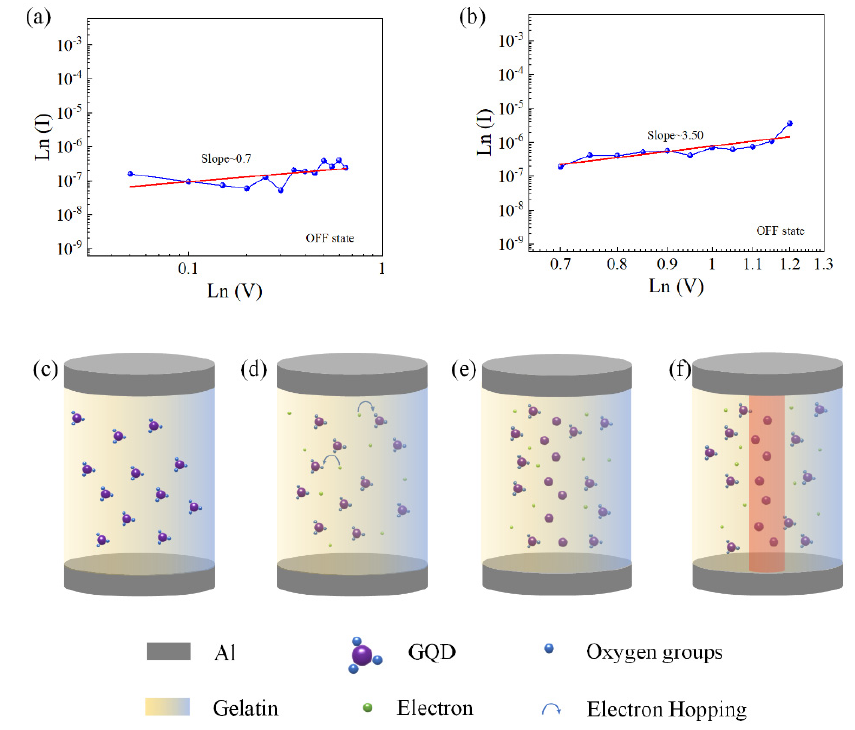
Figure 6. ( a , b ) Schematic diagram of the conduction mechanism of the device with a double logarithmic curve in the OFF state of the device. ( c ) The trapping center is in an unoccupied state. ( d ) The injected carriers are trapped by the GQD. ( e ) The trap is completely filled. ( f ) Forming conductive paths.